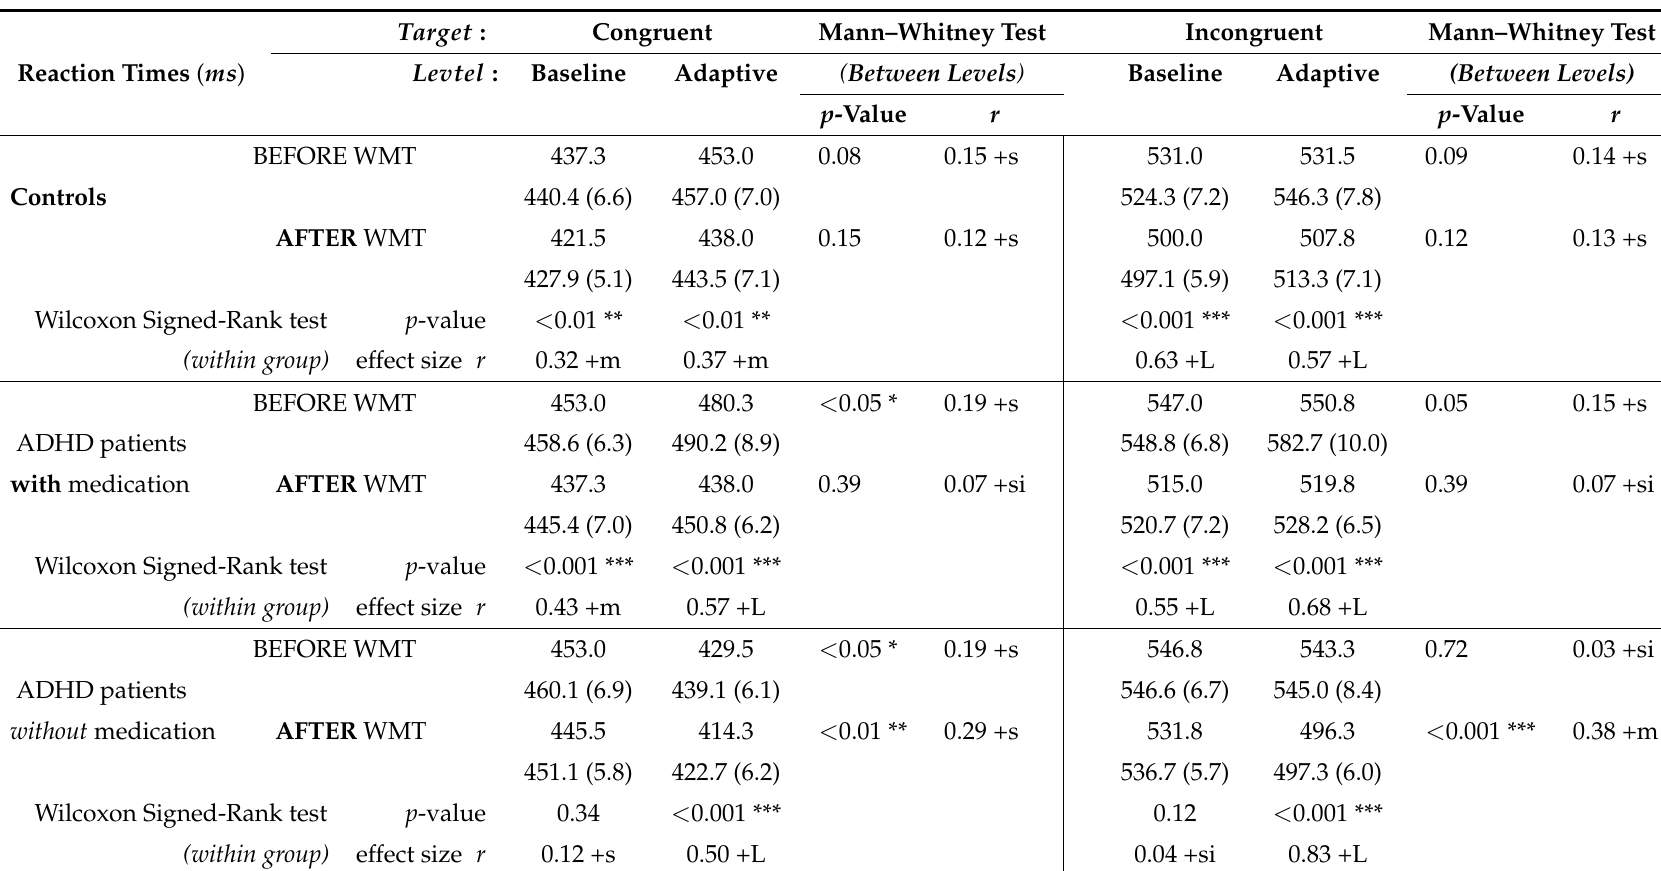
Table 3. Descriptive statistics (median, mean, and SEM) of reaction times for each group of participants and for any cue type (pooled together) as a function of Congruent and Incongruent targets. Comparisons between levels of training (Mann–Whitney test) and between before and after working memory training (WMT) within each group (Wilcoxon Signed-Rank test). For each test the corresponding p -values and effect size ( r ) are reported in the